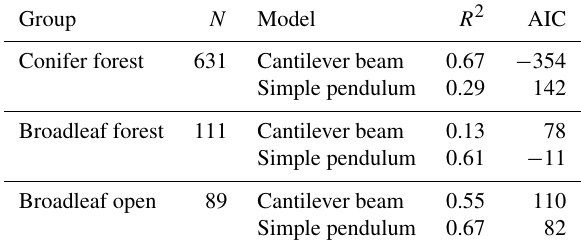
Table 2. Summary statistics for linear models predicting funda- mental frequency using the cantilever beam model and the sim- ple pendulum model for three groups of trees. The data were log- transformed prior to model